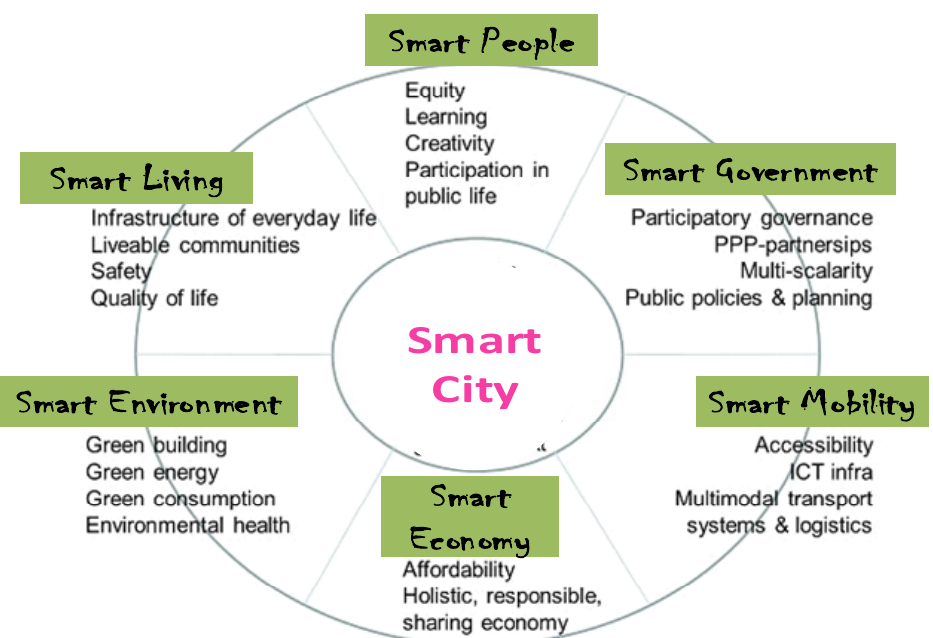
Figure 5. Smart City Wheel Conceptual Framework (adapted from [63,64]).